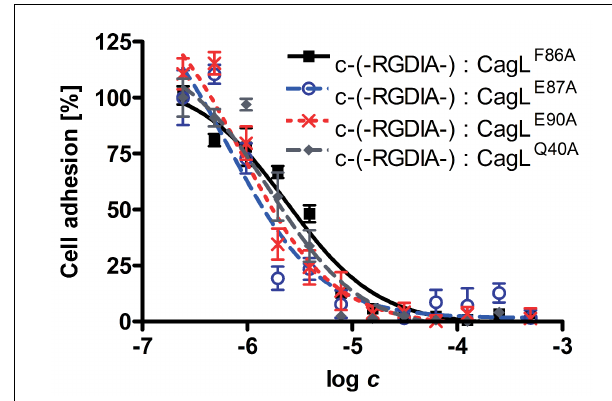
FIGURE 4 | Dose–response curves showing the inhibitory effect of cyclic RGD peptides onWM-115 cell binding to the different immobilized CagL proteins in competitive cell adhesion assays. The purified CagL Q40A , CagL F86A , CagL E87A , and CagL E90A mutant proteins were immobilized on plastic surface.WM-115 cells were pre-incubated with varying concentrations of cyclic peptide c-(-RGDlA-; d-amino acids in small letter), which is known to inhibitWM-115 cell binding to immobilized CagL in the low μ M range (Conradi et al., 2011). Subsequently, theWM-115 cells were incubated with the immobilized CagL mutants.The amount of WM-115 cells bound to immobilized CagL was quantified, and the resulting dose–response curves were evaluated with a non-linear fit to determine the binding inhibition potency of peptide c-(-RGDlA-) for the interaction of WM-115 cells with immobilized CagL.